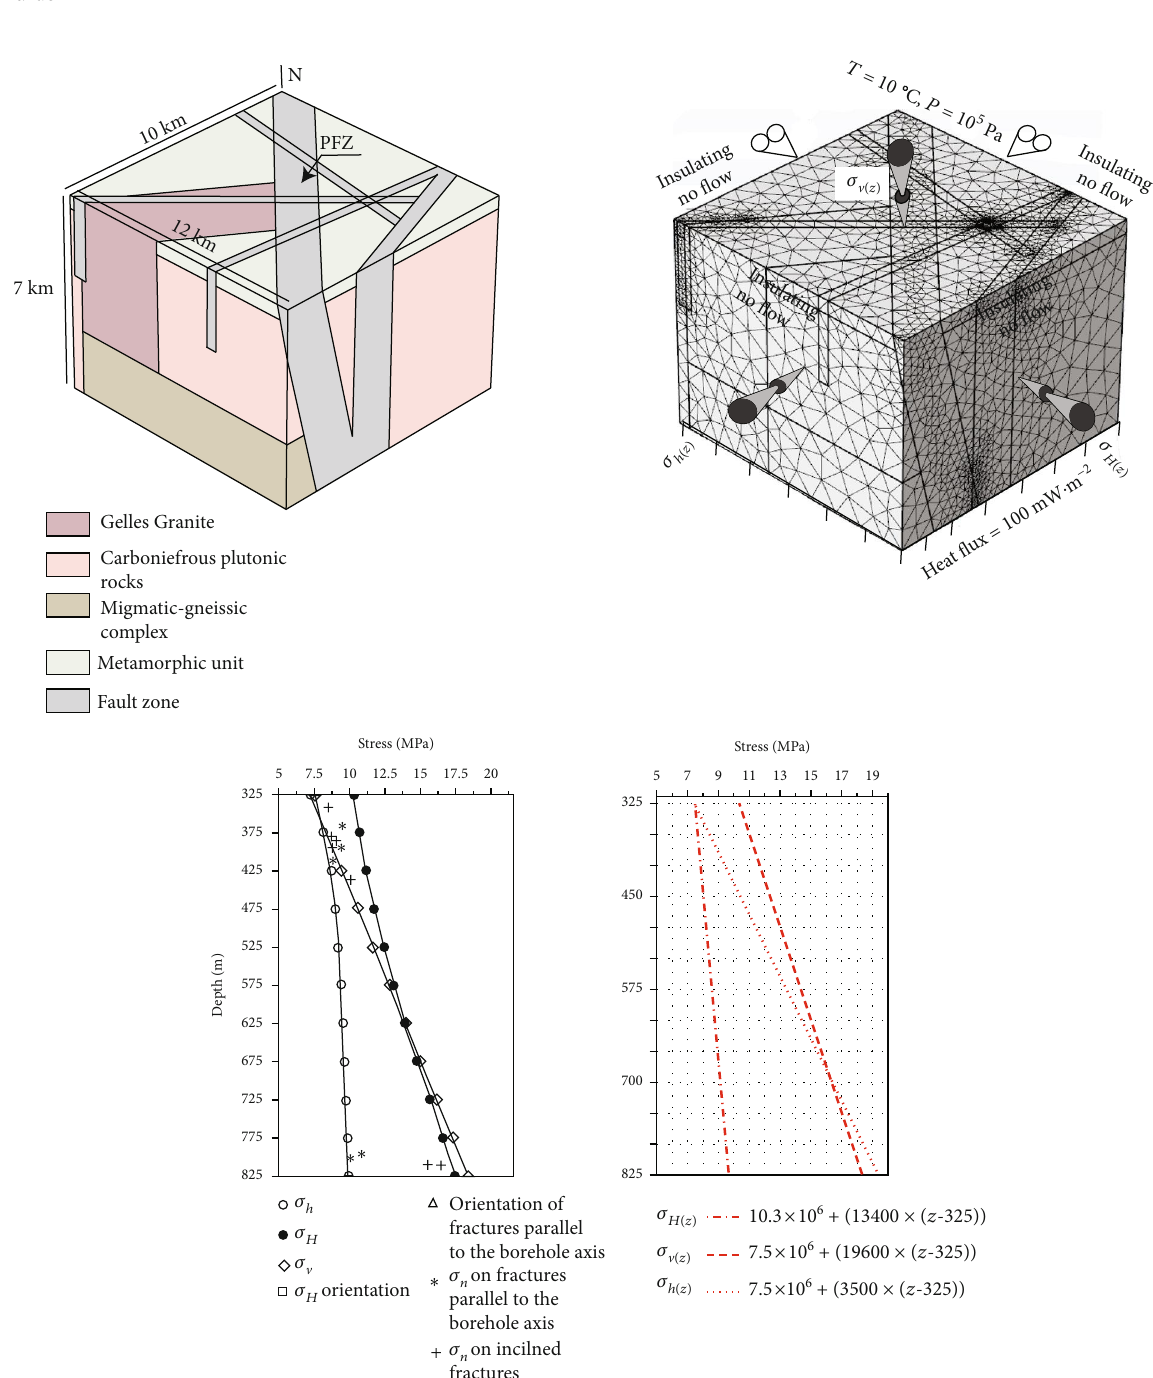
Figure 5: Geometry, meshing, and boundary conditions for numerical modelling of the Pontgibaud crustal fault zone. Numerical set-up is detailed in the text. Stress pro fi le of the Chassoles borehole (45.38 ° N, 3.09 ° E) (from [95]) integrated in Comsol Multiphysics ™